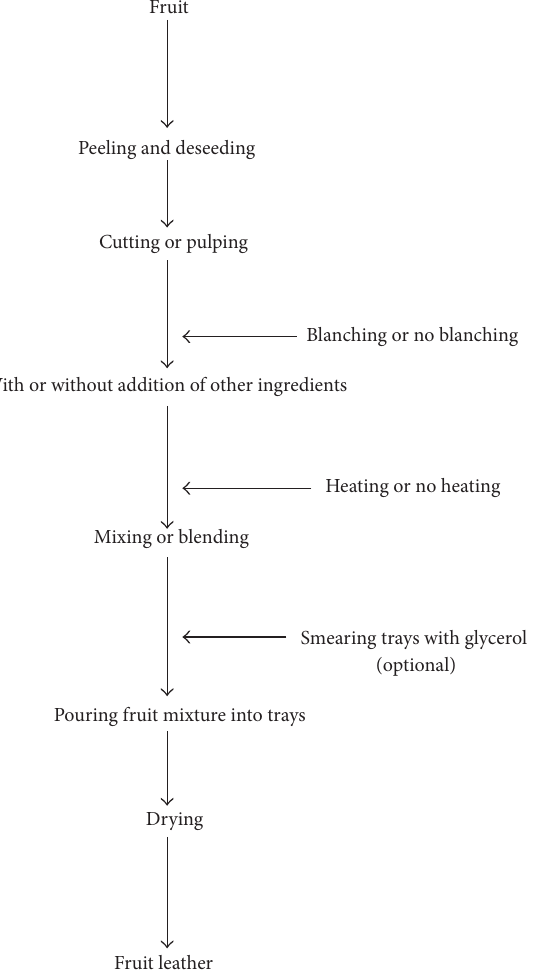
Figure 1: Schematic diagram of the general process for the produc- tion of fruit